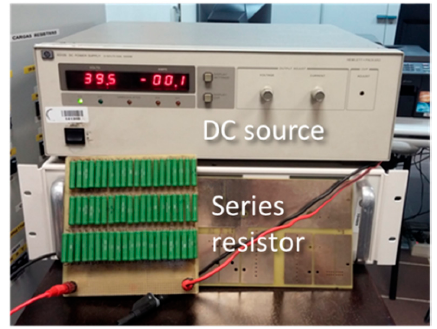
Figure 23. Fuel cell system emulator.